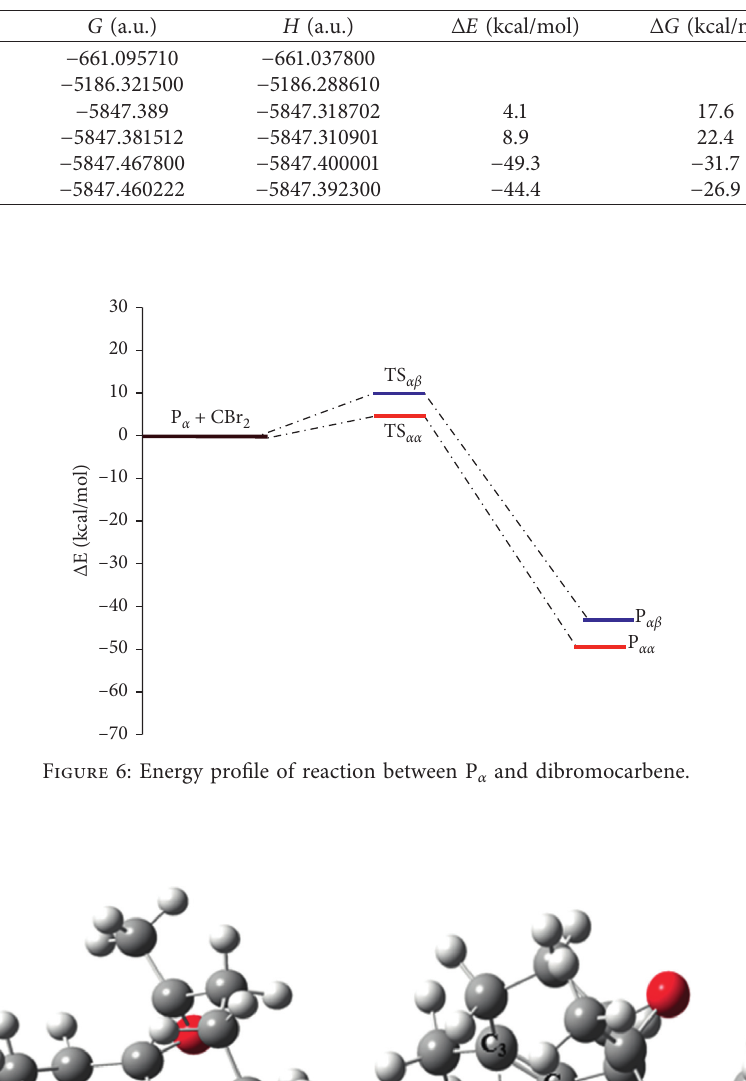
α and CBr 2 . (a) TS αα . (b) TS αβ